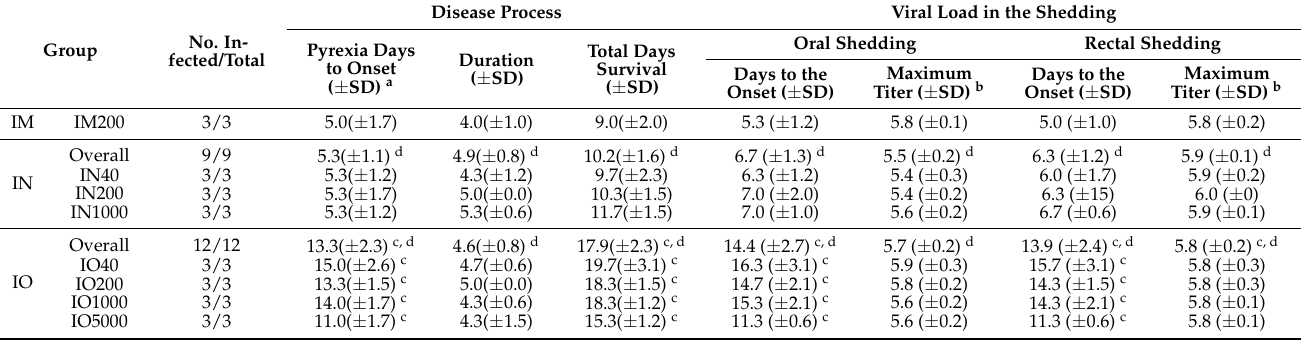
Figure 1. Survival rates and clinical scores in each group. ( A ) Inoculation of ASFV SY18 at 200 TCID 50 via the IM route; ( B – D ) Inoculation of ASFV SY18 at 40, 200, and 10,000 TCID 50 via the IN route; ( E – H ) Inoculation of ASFV SY18 at 40, 200, 1000, and 5000 TCID 50 via the IO route. The line indicating the clinical score for each pig is shown on the right Y-axis. The line indicating the group’s survival rate is on the left Y-axis. Table 2. Disease processes and virological parameters in pigs infected with ASFV SY18 by different routes and